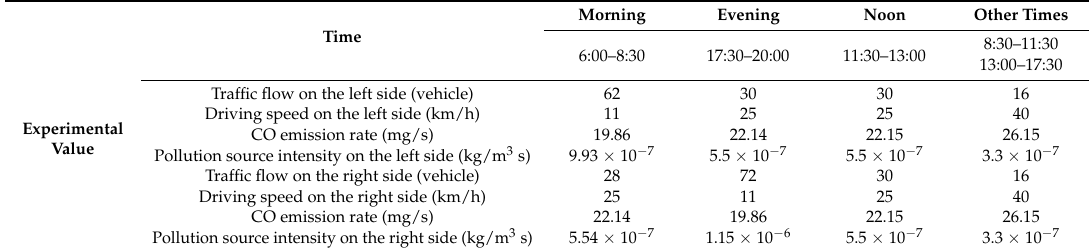
Table 2. Experimental values of pollution source intensity at different times during one